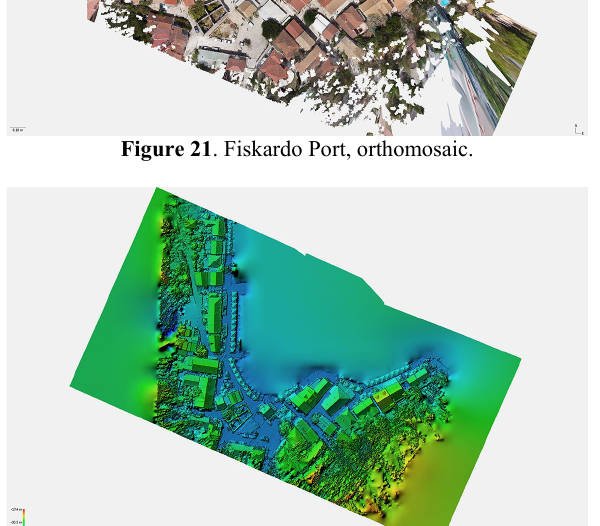
Figure 22 . Fiskardo Port, digital elevation-morphology model (dem).